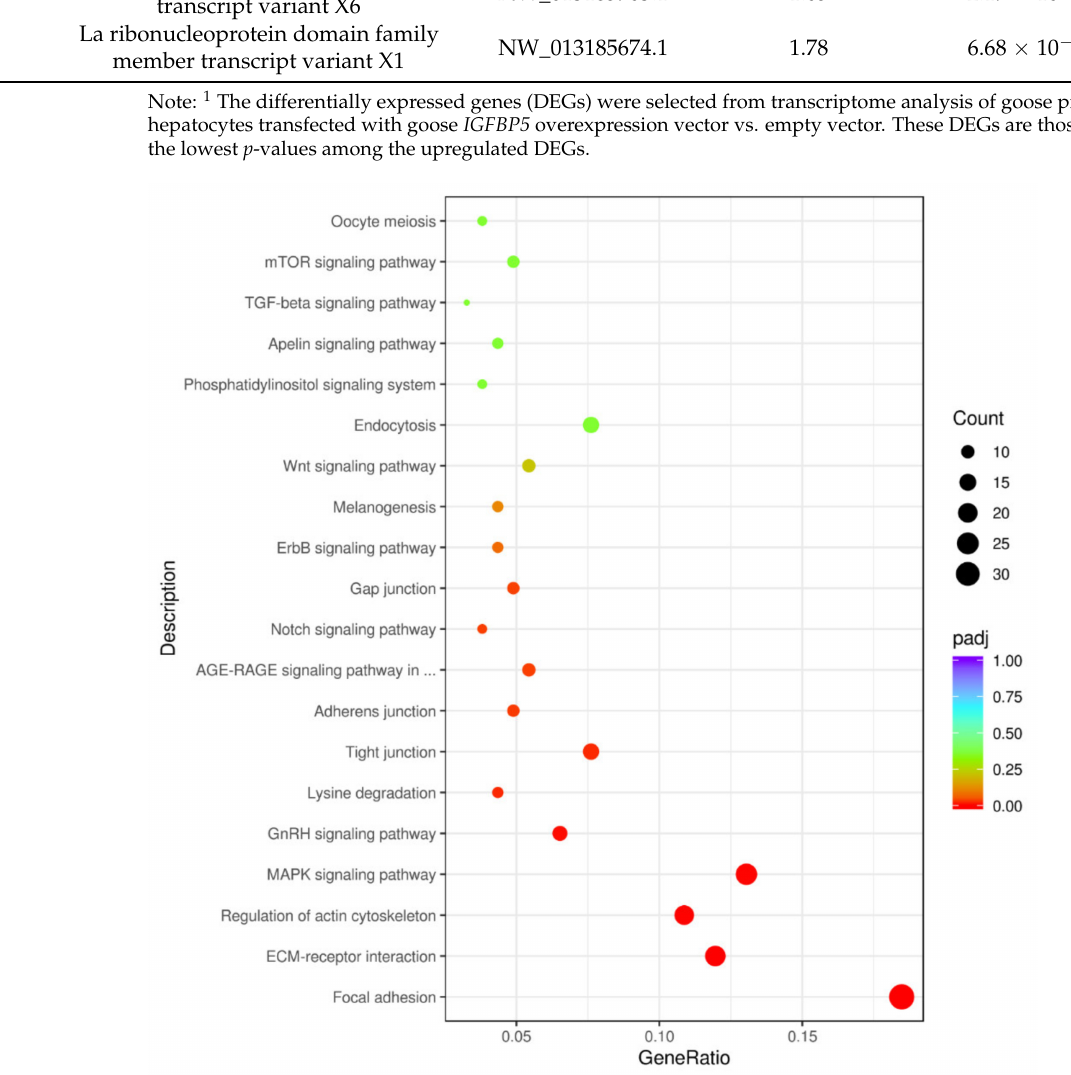
Figure 6. The KEGG pathway analysis showing the top pathways enriched with the differentially expressed genes between the goose primary hepatocytes transfected with IGFBP5 overexpression vector and empty vector. Note: The abscissa indicates the ratio of the number of the annotated differentially expressed genes on a specified KEGG pathway to the total number of the annotated differentially expressed genes, and the ordinate indicates the significance of enrichment. The colors denote the adjusted p -value (padj), and the sizes of the dots denote the number of the differentially expressed